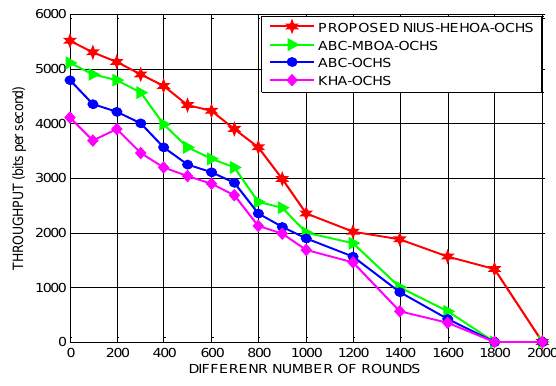
Figure 3 . Proposed NIUS-HEHOA-OCHS: Mean Throughput under different rounds